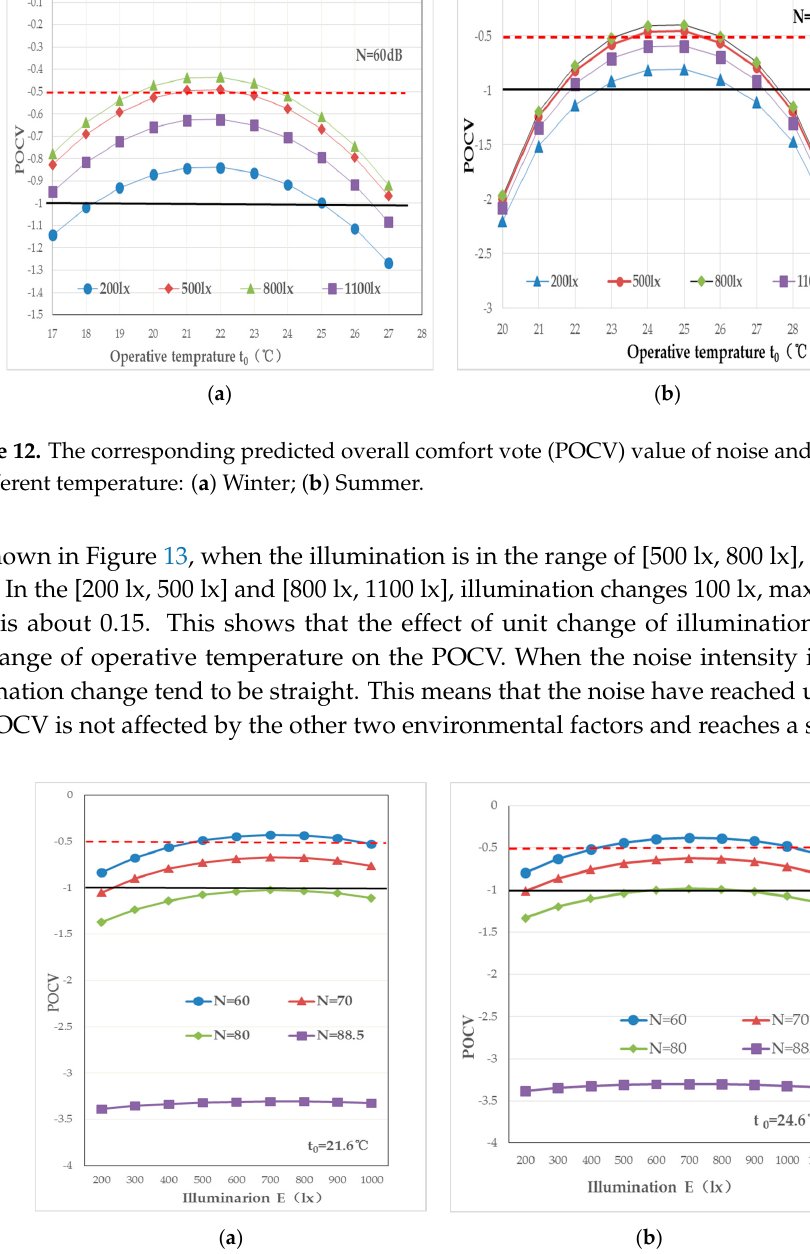
Figure 13. The corresponding POCV value of operative temperature and noise at different illumination: ( a ) Winter; ( b ) Summer.